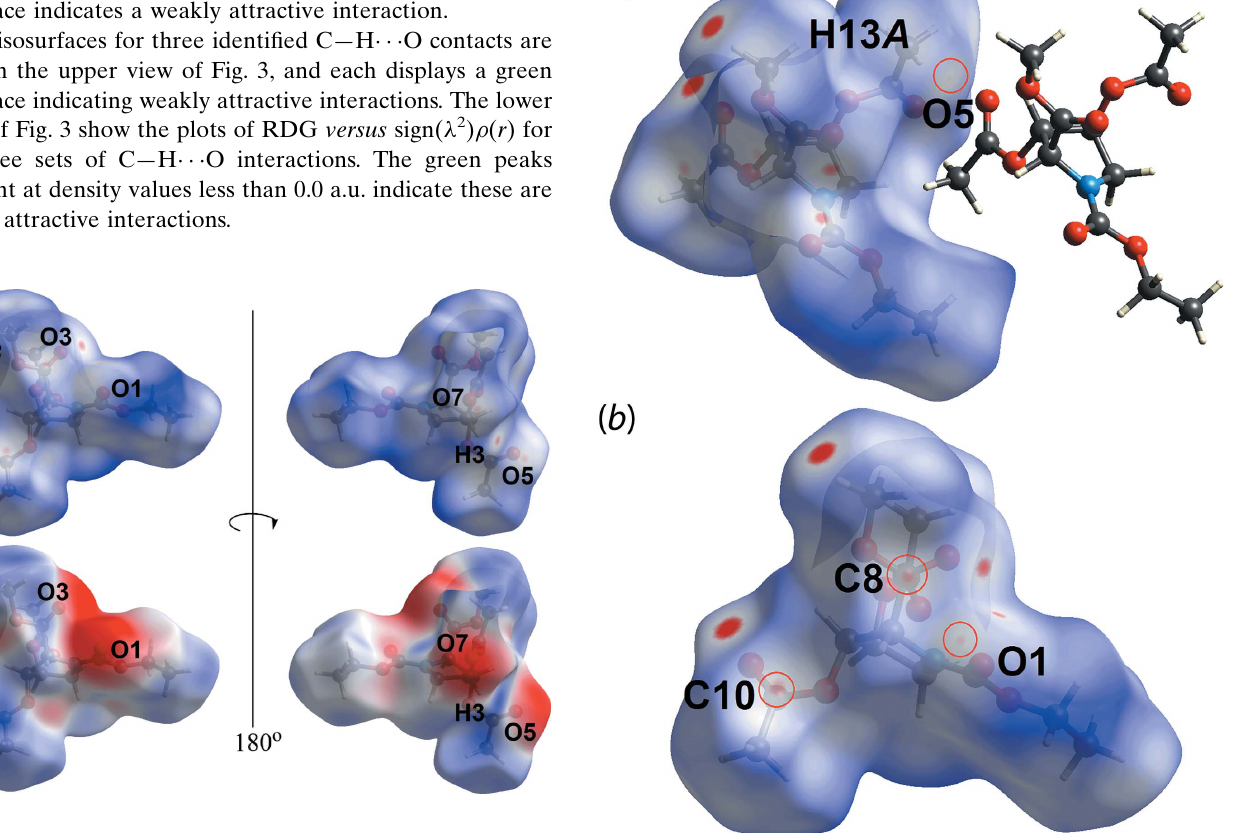
Figure 5 Views of the Hirshfeld surface mapped over d norm for (II) in the range (cid:6) 0.083 to +1.828 arbitrary units, highlighting within red circles ( a ) a weak C—H (cid:3)(cid:3)(cid:3) O interaction and ( b ) C (cid:3)(cid:3)(cid:3) O